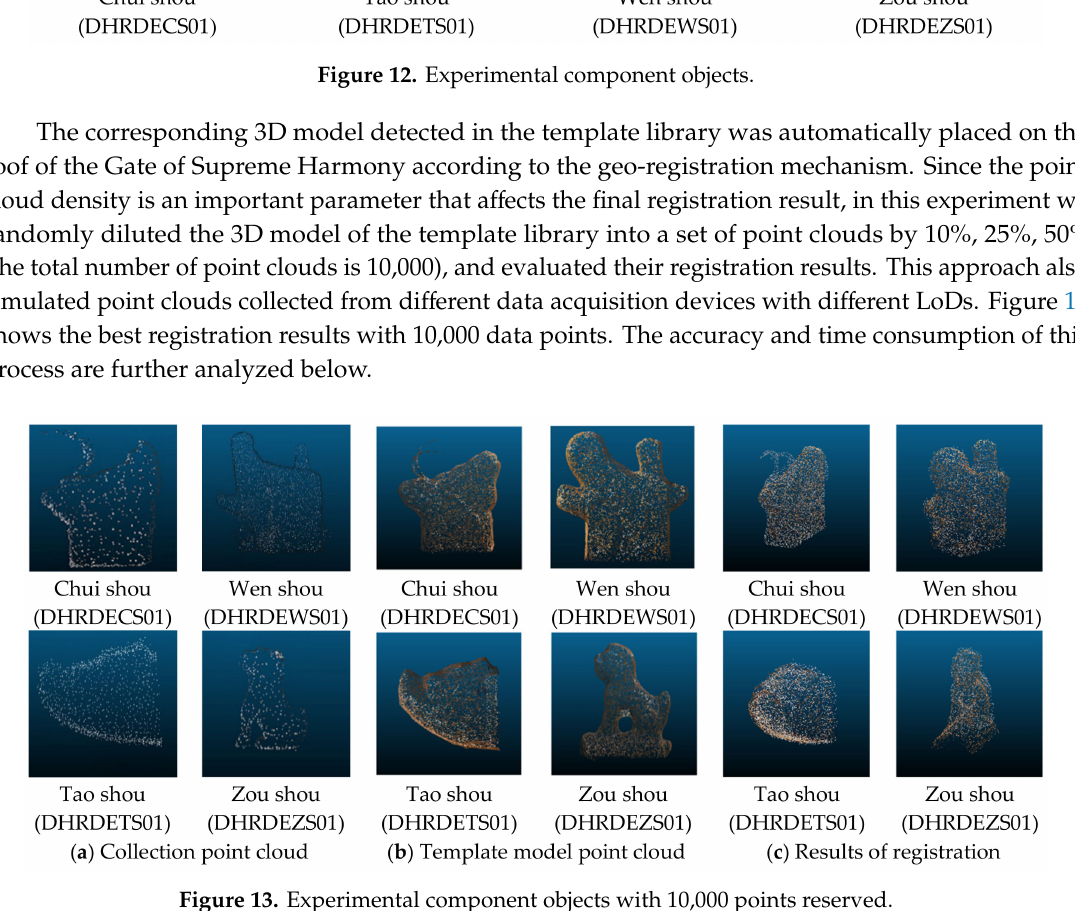
Figure 13. Experimental component objects with 10,000 points